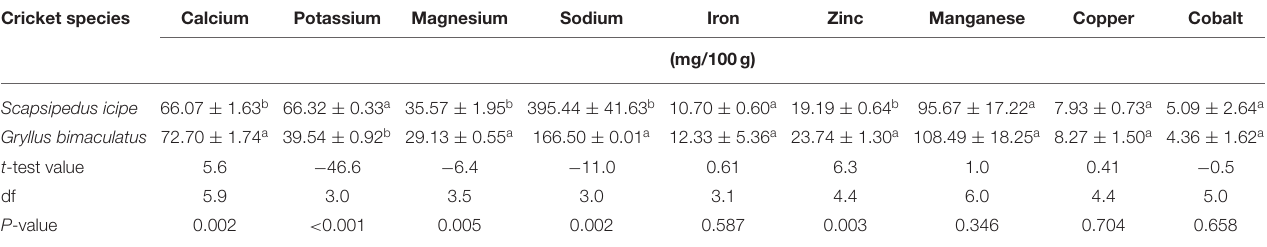
TABLE 3 | Mineral composition of edible cricket species ( Scapsipedus icipe and Gryllus bimaculatus ) in milligrams/100 grams on dry matter basis (mean ± SE). Cricket species Calcium Potassium Magnesium Sodium Iron Zinc Manganese Copper Cobalt